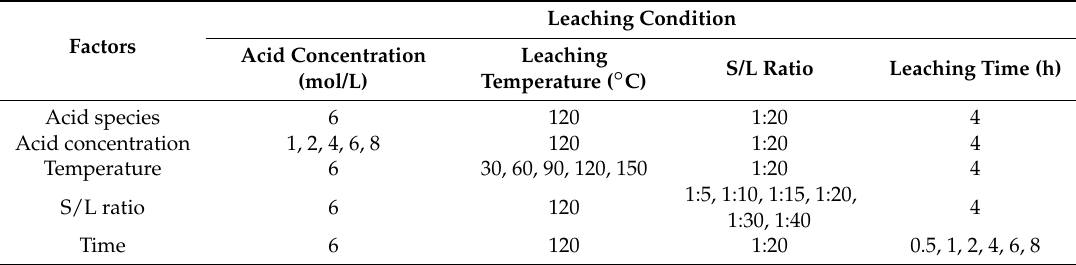
Table 2. Intensified acid leaching conditions. Abbreviations: S/L, solid to